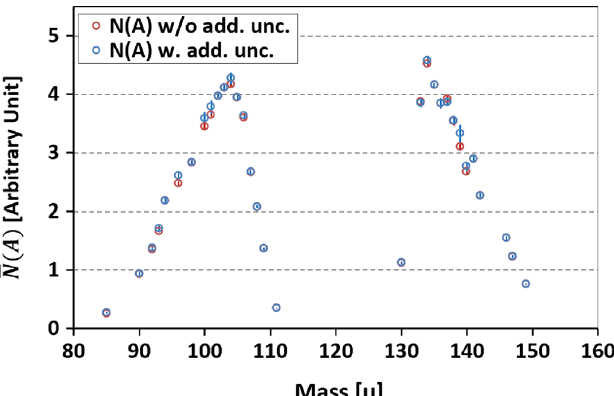
Fig. 6. The N ð A Þ distribution with (in blue) and without (in red) the additional dispersion uncertainties (add. unc.) for Exp.2. Fig. 4. The correlations obtained in the analysis procedure for